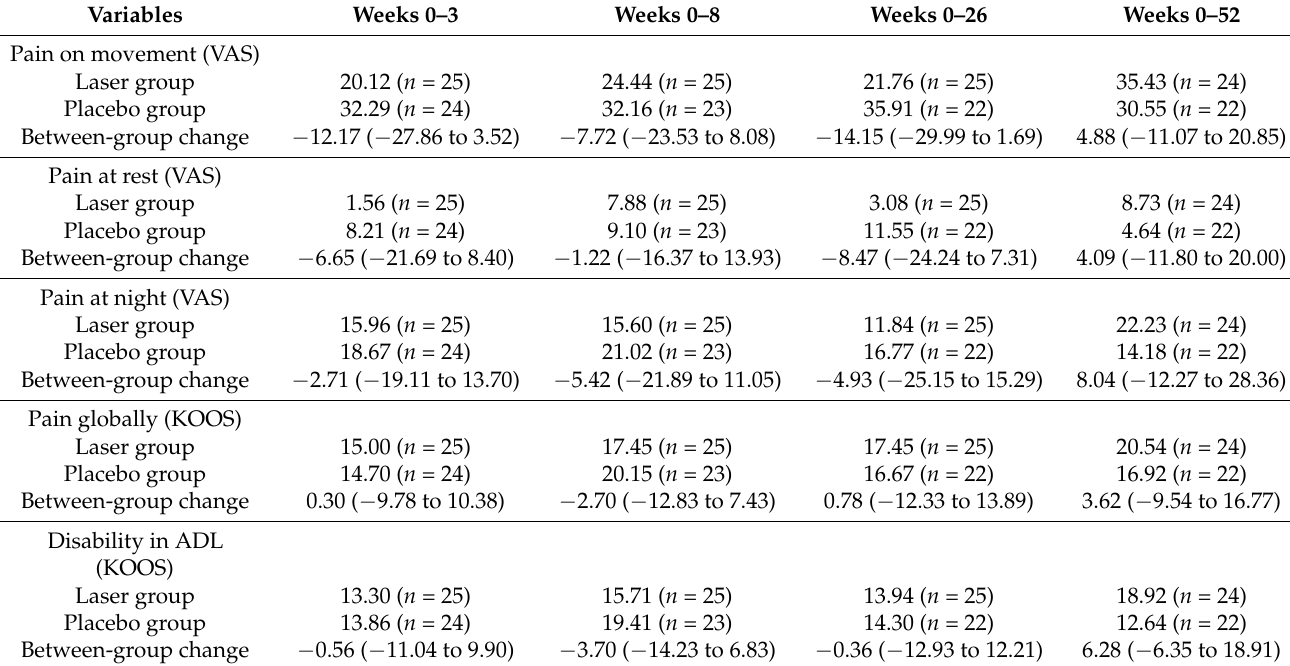
Table 2. Patient-reported outcomes: within- and between-group changes from baseline (higher score is